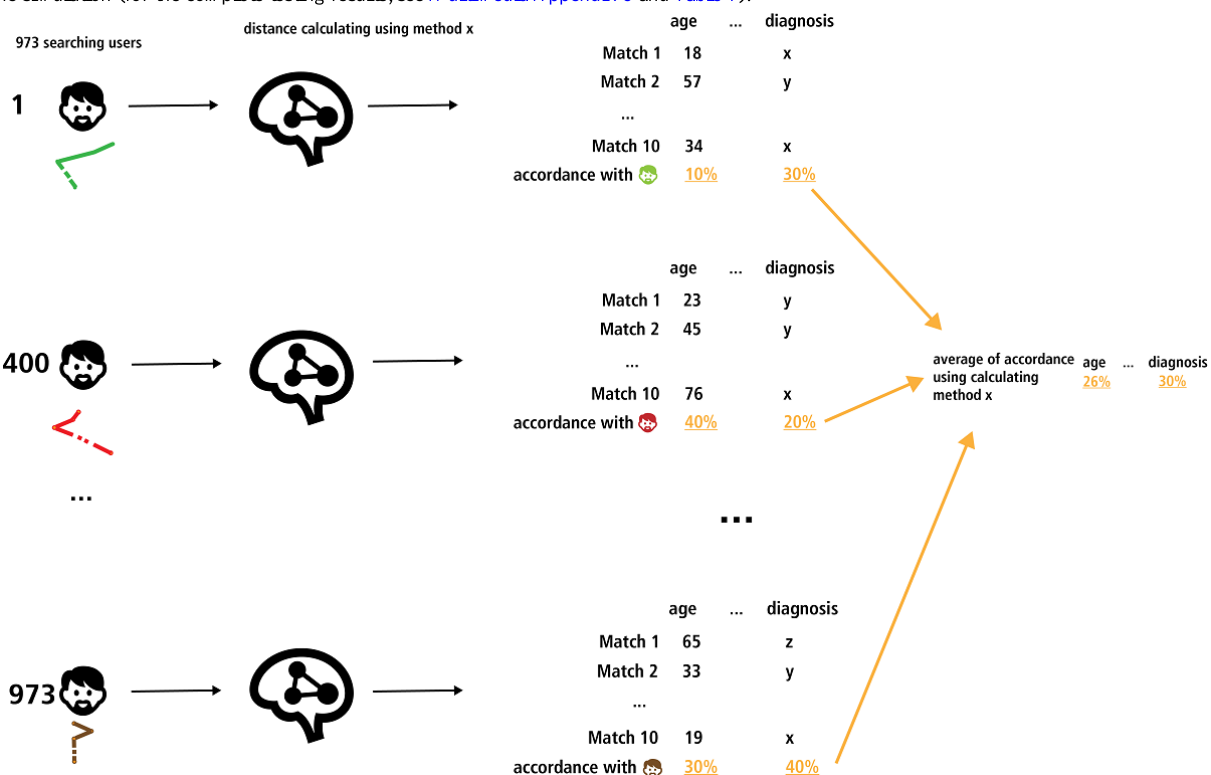
Figure 6. Schematic illustration of the second part: identifying a matching method for a given data set of users with rare diseases. Ten matches for all 973 data sets with one calculating method, calculating the average of the matching accordance of properties. This figure illustrates the basic principle of the simulation (for the complete testing results, see Multimedia Appendix 5 and Table